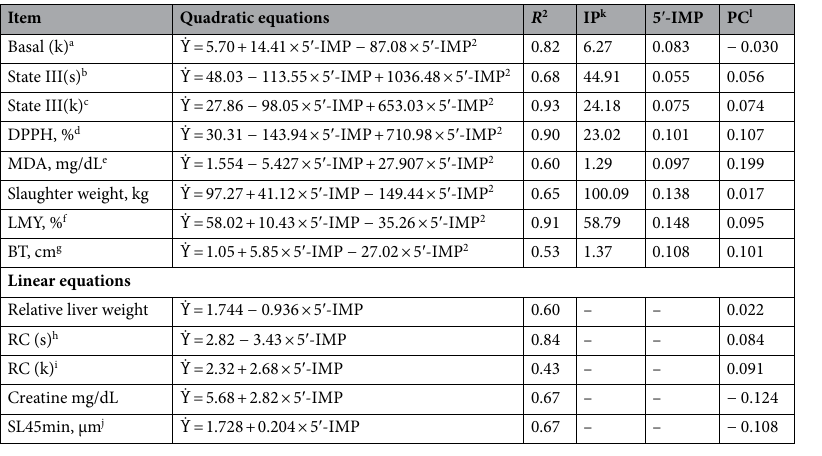
Table 2. Fitted regression equations for the studied parameters as a function of dietary inosine-5 ′ - monophosphate (5 ′ -IMP) level. a Basal state respiration rate in liver mitochondria incubated with α-ketoglutarate. b State III respiration rate in liver mitochondria incubated with succinate, stimulated by ADP. c State III respiration rate in liver mitochondria incubated with α-ketoglutarate and stimulated by ADP. d Free radical scavenging assay. e Malondialdehyde concentration. f Lean meat yield. g Backfat thickness. h Respiratory control of liver mitochondria incubated with succinate. i Respiratory control of liver mitochondria incubated with α-ketoglutarate. j Sarcomere length at 45 min after slaughter. k Inflection point. l Positive control diet (0.00% 5 ′ -IMP and 3300 kcal